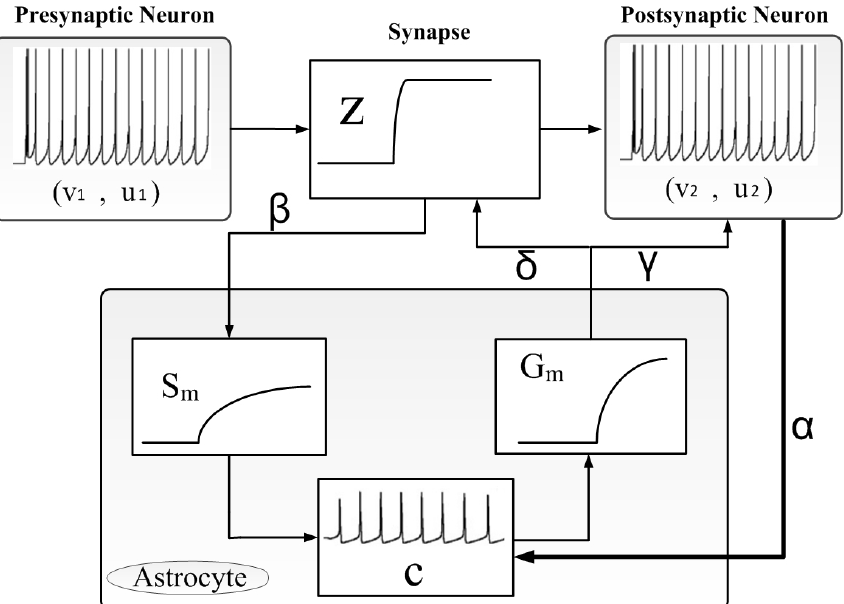
Figure 2. Mechanisms of interaction between neurons and astrocyte in the tripartite synapse based on coupling coefficients, α , β , γ , δ